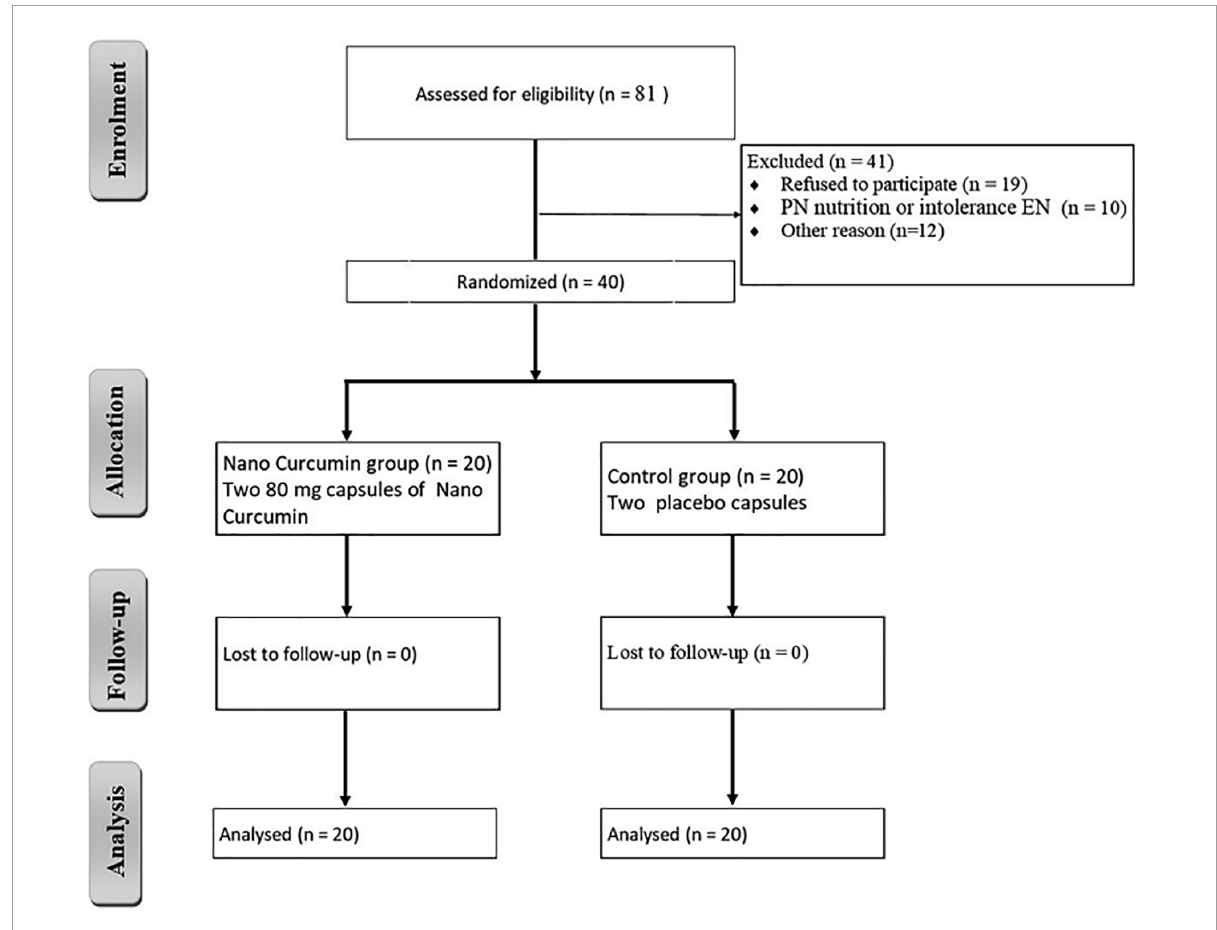
FIGURE1 Study flow